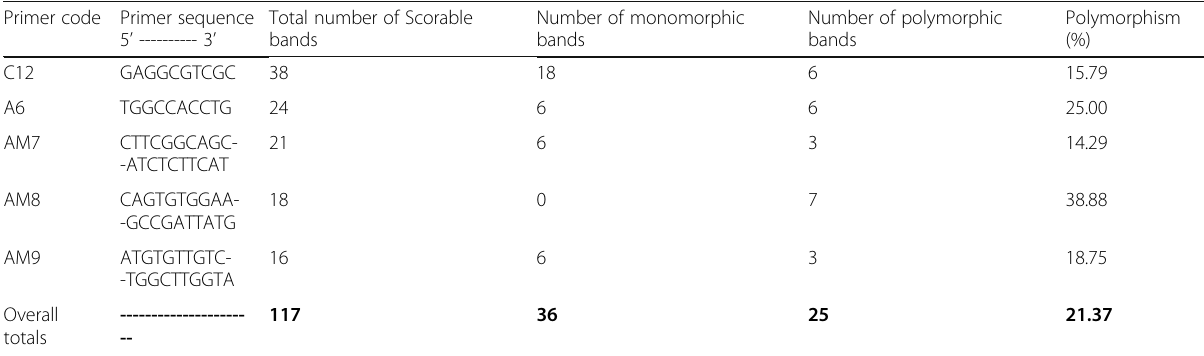
Table 3 RAPD-PCR amplification products of DNA extracted from different samples of J. curcas plants using different five random